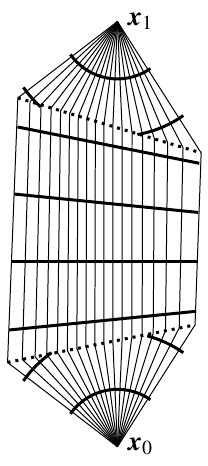
Figure 2: Another possible set of paths corresponding to the same observed events as Figure 1, only this time the corre- sponding field has two distinct phase